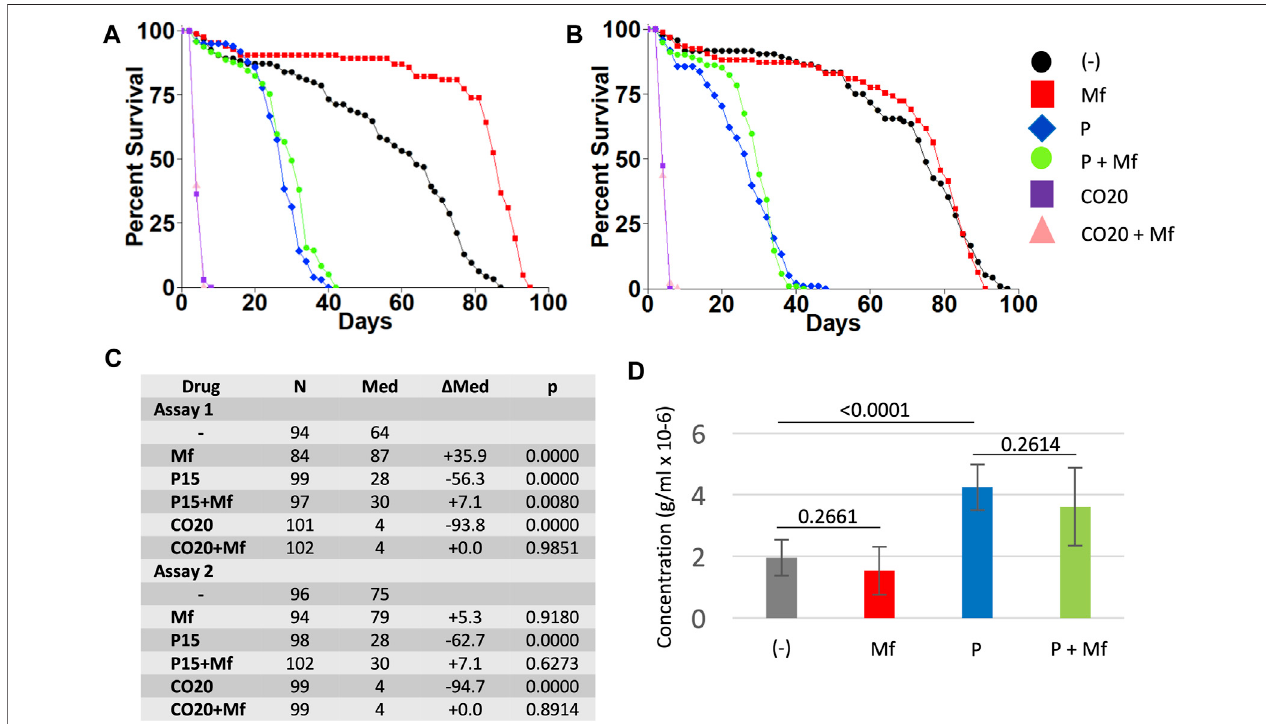
FIGURE3| Effectofparaquatonvirginfemalelifespaninthepresenceandabsenceofmifepristonetreatment,andeffectofmifepristoneonvirginfemaleson20% coconutoilmedia.Virginfemaleswereassayedforlifespanoncontrolmedia,mediasupplementedto15 mMparaquat(P),andmediasupplementedwith20%coconut oil(CO20),intheabsence( − )andpresence(Mf)of200 μ g/mlmifepristone. (A) Assay1. (B) Assay2. (C) Statisticalsummaryforassays1and2,includingmedianlifespan and log-rank test results. Control media is compared to P and to CO20. For each media type, ( − ) drug is compared to mifepristone-treated (Mf). The p value for signi fi cance with fi ve comparisons is 0.01. COX proportional hazards analyses are presented in Supplementary Table S1 . (D) Food intake determined using EX-Q assay.Dataiscombined forassays1and 2, and ispresentedas mean ± SDofeightreplicates of10 fl ies each.EX-Q assay wasnot feasible forCO20 fl ies due tolimited survival.Foreachmediatype,( − )drugiscomparedtomifepristone-treatedgroup(Mf)usingunpaired,two-sided t test,and p valuesarepresentedabovethebars.The p valueforsigni fi cancewith onecomparison is0.05. Datafor theindividual assaysispresented in Supplementary Figure S1 , and ANOVAanalysesforthe individualand combined assays is presented in Supplementary Table S2